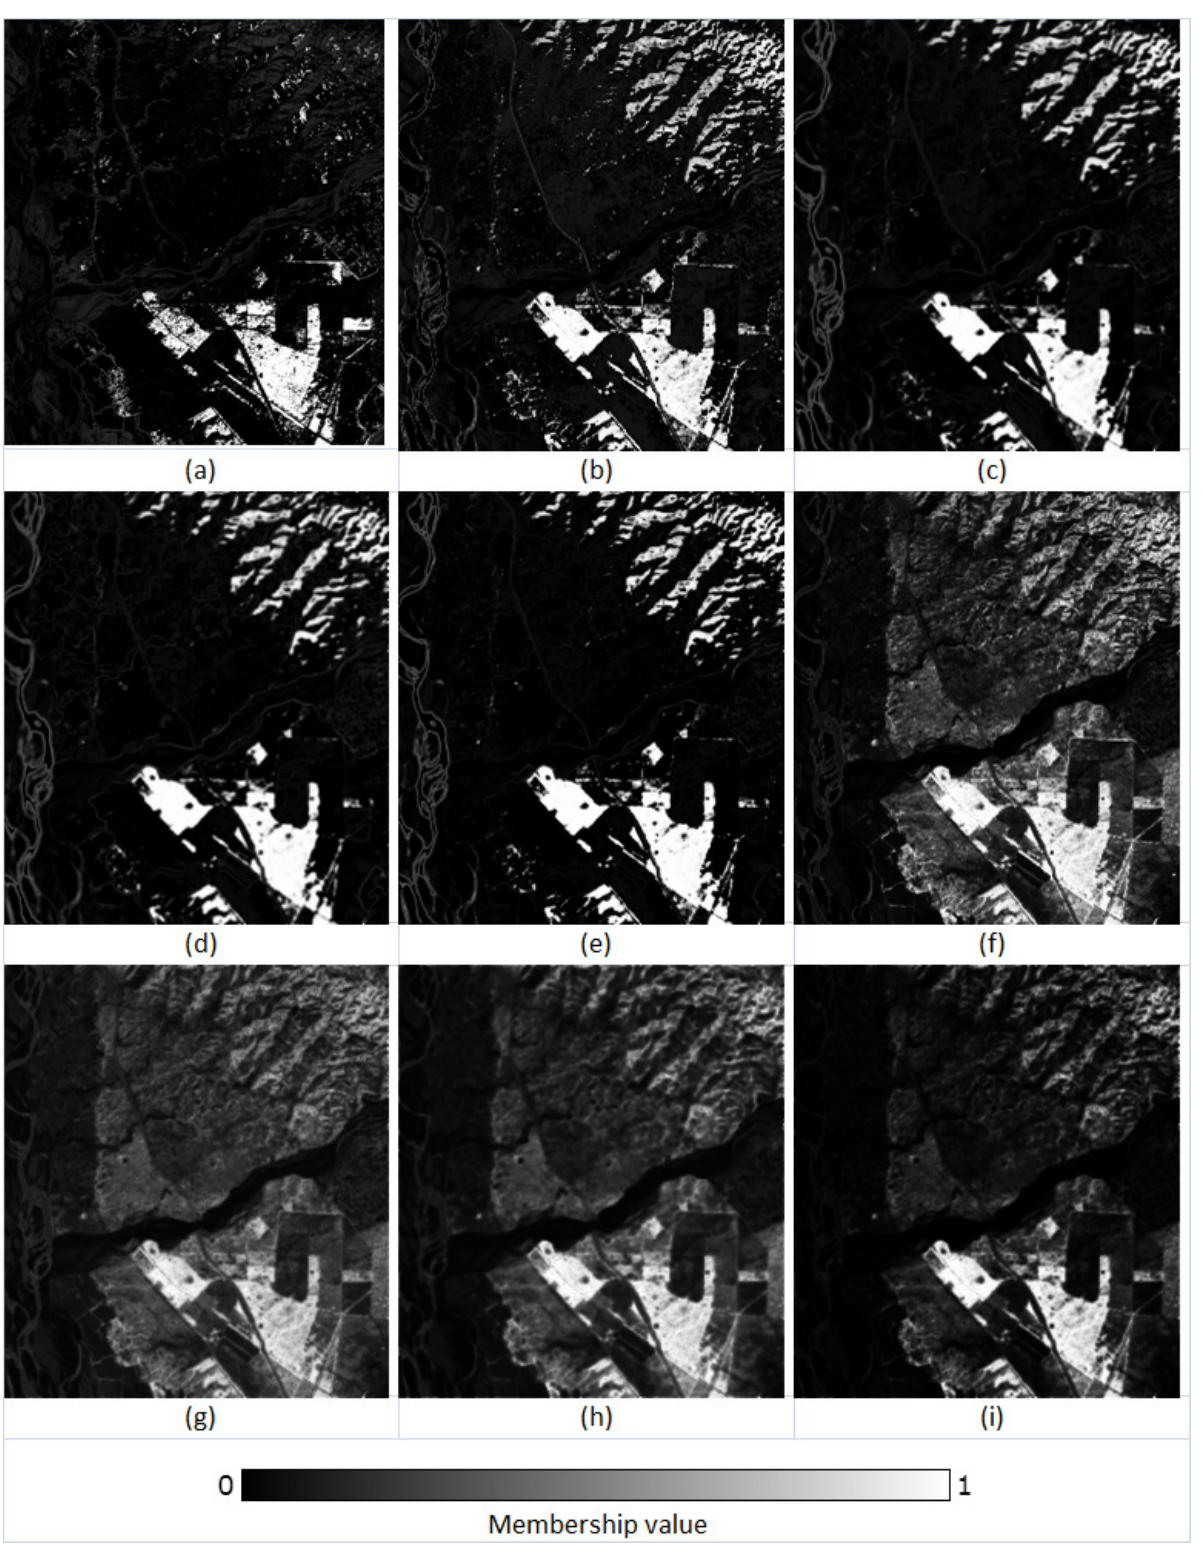
Figure 5. The membership fraction (0–1) for the class ‘Eucalyptus’ in ( a ) reference, ( b ) FCM output, ( c ) FCM-S output, ( d ) FLICM output, ( e ) ADFLICM output, ( f ) PCM output, ( g ) PCM-S output, ( h ) PLICM output, and ( i ) ADPLICM output.